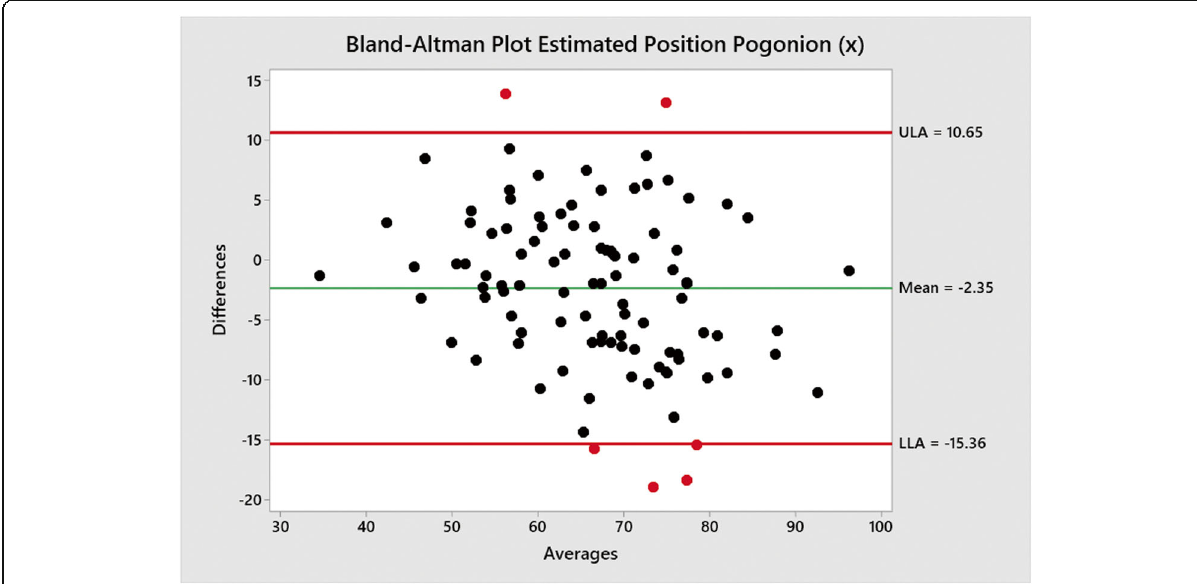
Fig. 4 Bland-Altman plot showing mean differences between traced position of Pog ( x ) co-ordinate and estimated position by Sassouni+ analysis versus mean (average); the mean difference and limits of agreement are shown